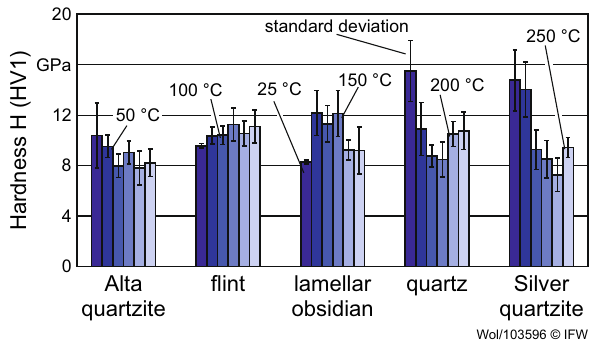
Fig. 3 Vickers hardness of the rocks at different